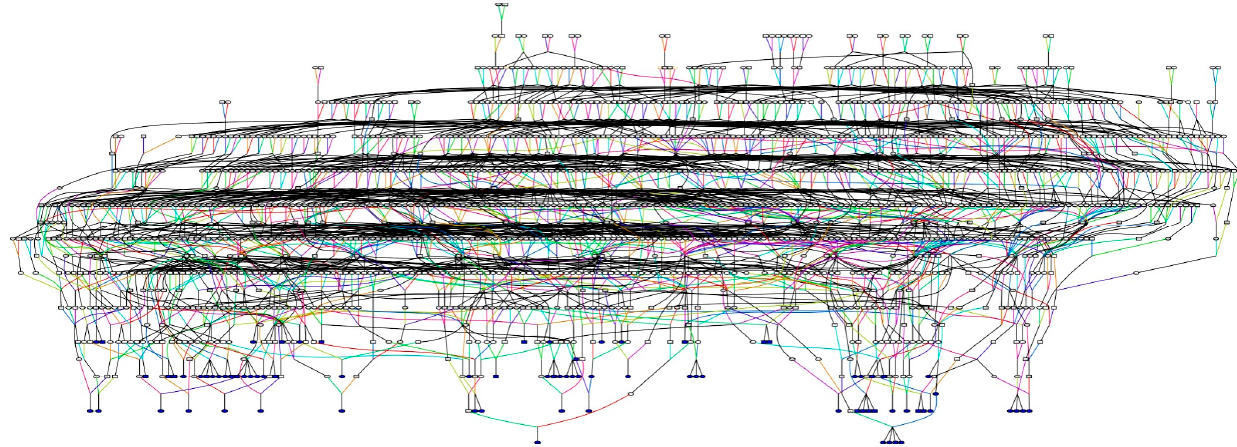
Figure 1. All-connecting path pedigree of GGLEAM study participants. This multigenerational pedigree connects 80 of the 81 Amish individuals enrolled in the GGLEAM study and includes 1586 individuals. Genealogy data was obtained from the Anabaptist Genealogy Database (AGDB) [43]. The 80 GGLEAM study participants are highlighted in blue. Men are represented by squares, and females are represented by circles. Pedigree was drawn using the Pedigraph software tool.